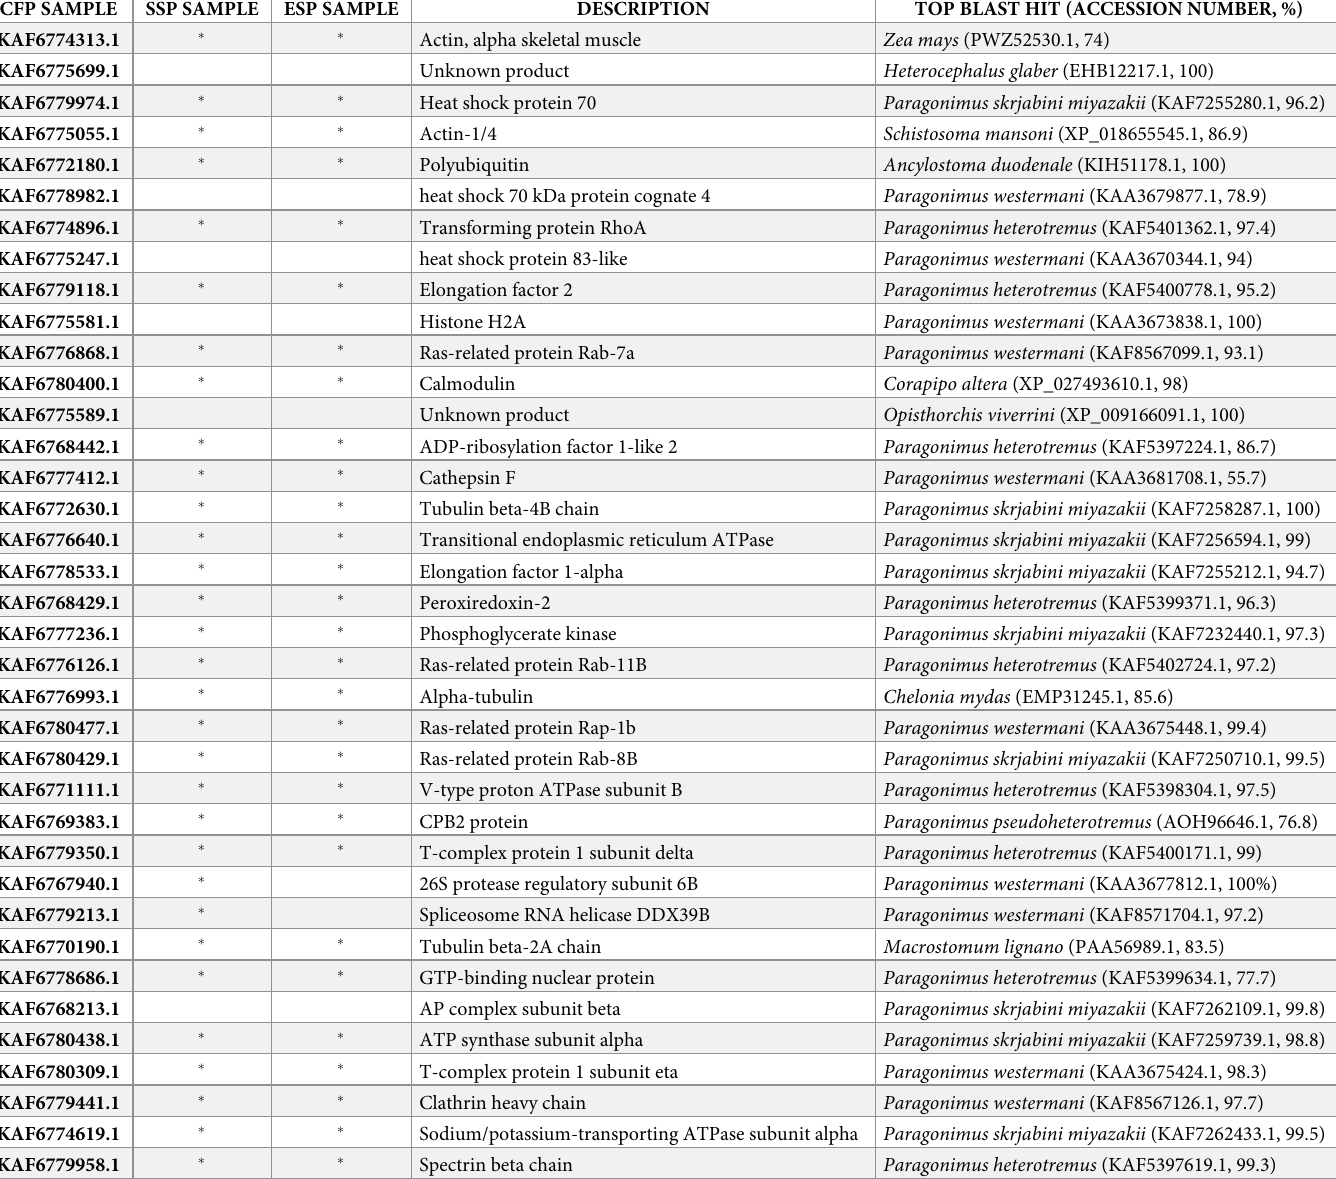
Table 1. Proteins found in the CFP sample type. In the first row are the accession numbers of each of the 37 parasite-derived proteins found in the CFP sample type. Presence of these proteins in the somatic soluble proteins (SSP) sample type and excretory/secretory proteins (ESP) sample type are marked with an asterisk. The GenBank accession number of the top blast hit and it similarity to the match is given in parenthesis. The proteins are ordered from the most to the least abundant in the CFP sample type. CFP SAMPLE SSP SAMPLE ESP